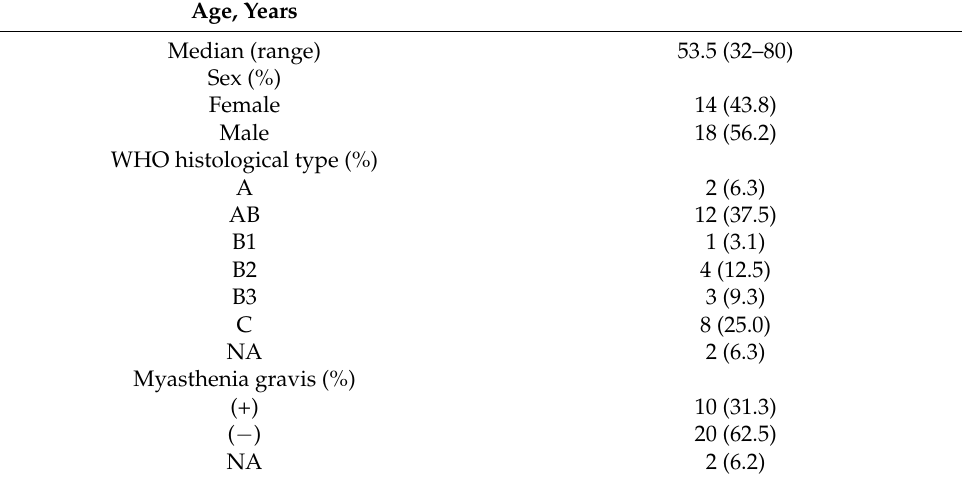
Table 2. Patient